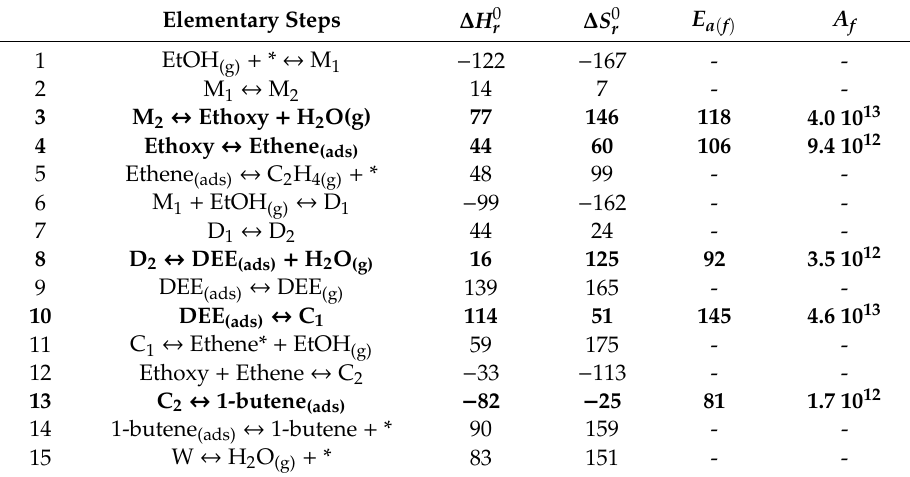
Table 2. Standard reaction enthalpy ( ∆ H 0 r in kJ mol − 1 ), standard reaction entropy ( ∆ S 0 r in J mol − 1 K − 1